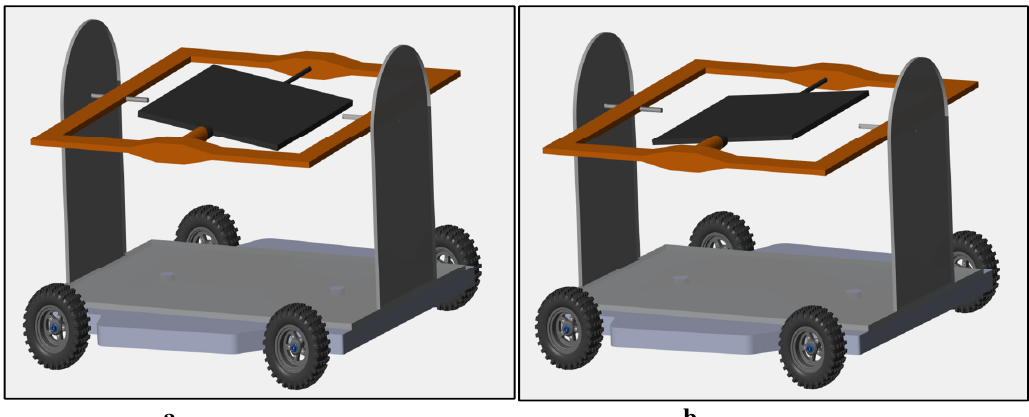
a b Fig. 13. Self-balancing of the (platform on the mobile car) structure in the virtual simulation a) under tilt angle 10° on positive Y-axis b) under tilt angle -10° on negative Y-axis.